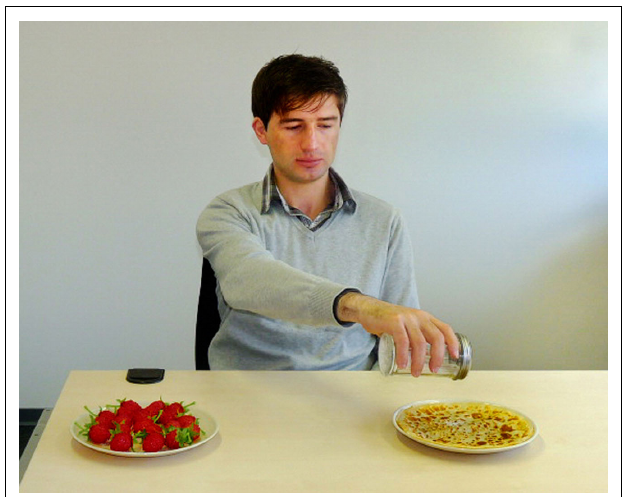
FIGURE 1 | Example video snapshot: the experimenter sugars the pancakes.